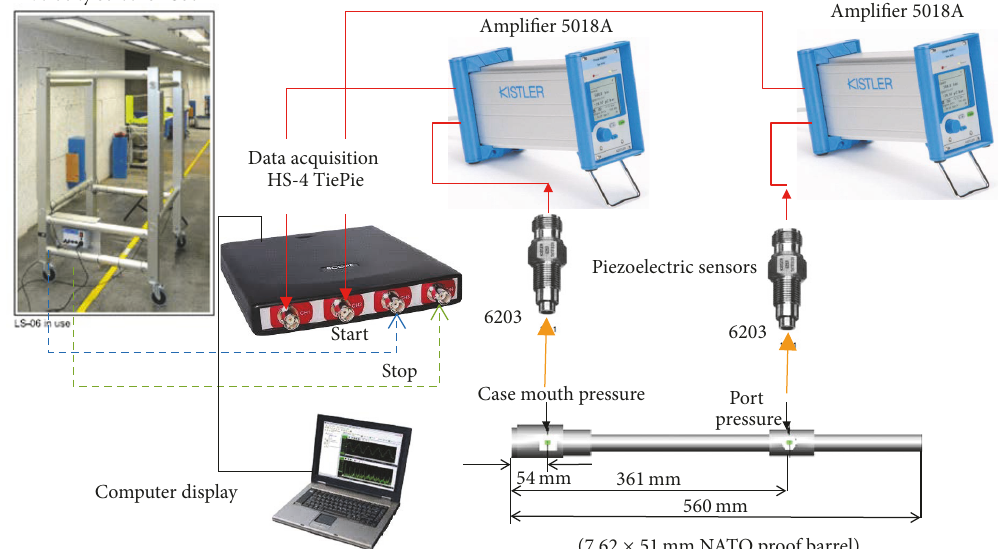
Figure 3: Schematic of Electronic Pressure, Velocity, and Action